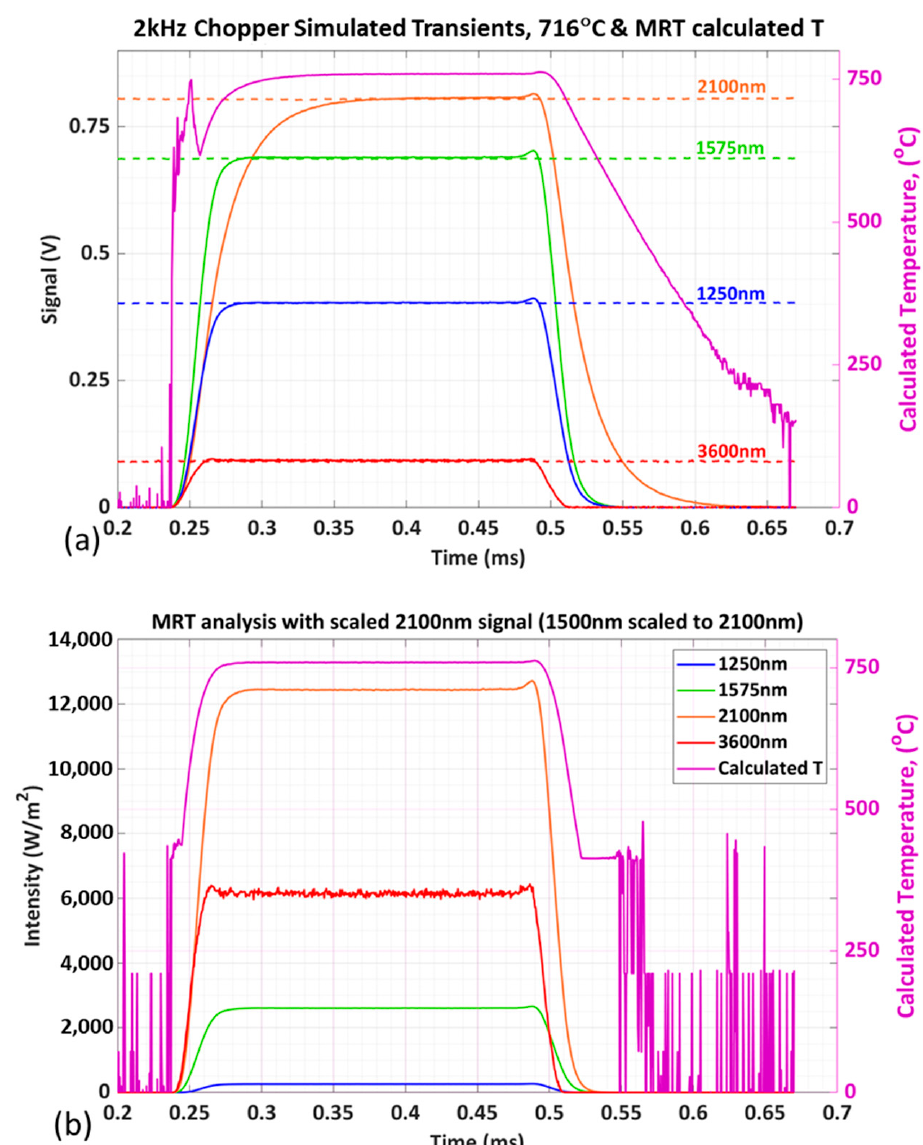
Figure 8. ( a ) Synthetic 2 kHz surface-emission transient from the LNF-valve sample at 716 °C using the chopper assembly shown in Figure 7. Individual signal transient from the four spectral channels and related transient MRT analysis results. Dashed lines are the signals at a steady state (without chopper). ( b ) Individual signal transient from the four spectral channels, with the slow 2100 nm channel replaced by a scaled version of the fast 1500 nm channel signal transient, and related transient MRT analysis results.